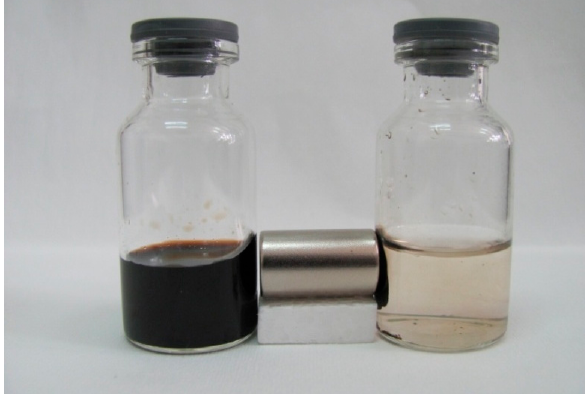
Figure 9. Aqueous dispersion of the MIONs prepared with: 0.768 mM ( left ); and 0.072 mM ( right ) concentrations of PTMP-PMAA under the effect of external magnetic (1.5 T) after 1 h.